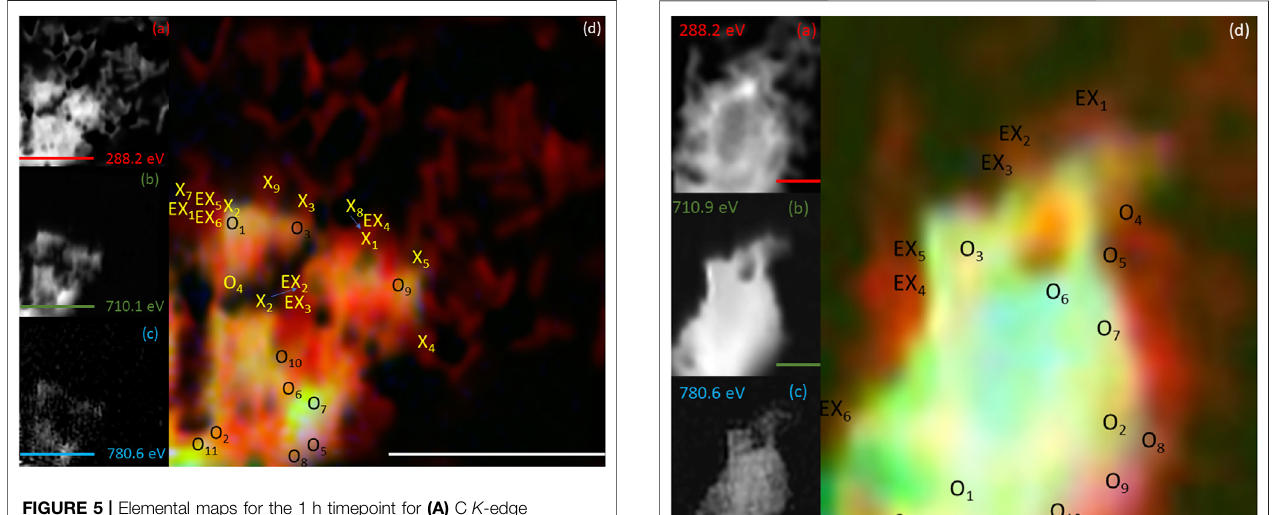
FIGURE 5 | Elemental maps for the 1 h timepoint for (A) C K -edge (288.2 eV; red), (B) Fe L 2,3 -edge (710.1 eV; green) and (C) Co L 2,3 -edge (780.6 eV; blue). The corresponding composite RGB (red, green, blue) image (D) shows the spatial relationship between the bacterial cells (C K -edge) andtheminerals(FeandCo L 2,3 -edges).Spectraweretakenfromregionsco- located with the bacterial cells (X or EX) and regions not co-located to the bacterial cell (O). The centre of the “ X ” and “ O ” denote the precise location from which the spectra were collected. All scale bars are 7 μ m.